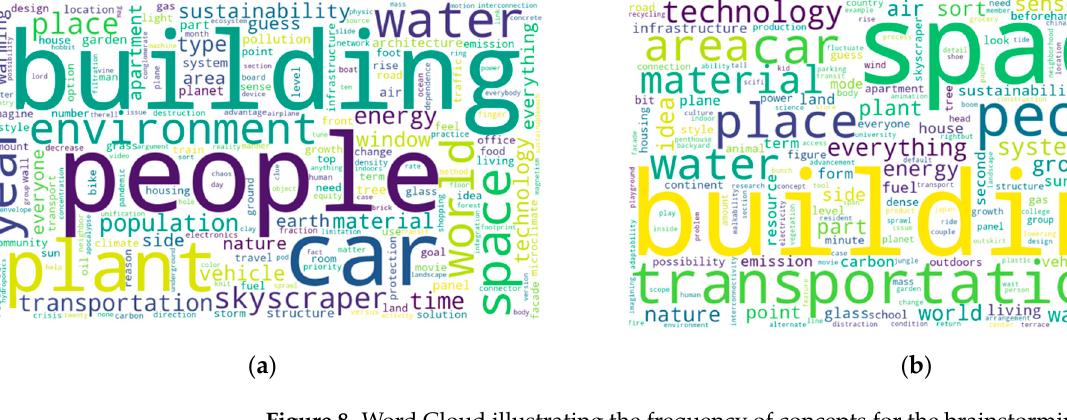
Figure 8. Word Cloud illustrating the frequency of concepts for the brainstorming tasks in a room with an algae facade ( a ) and without an algae facade ( b ).